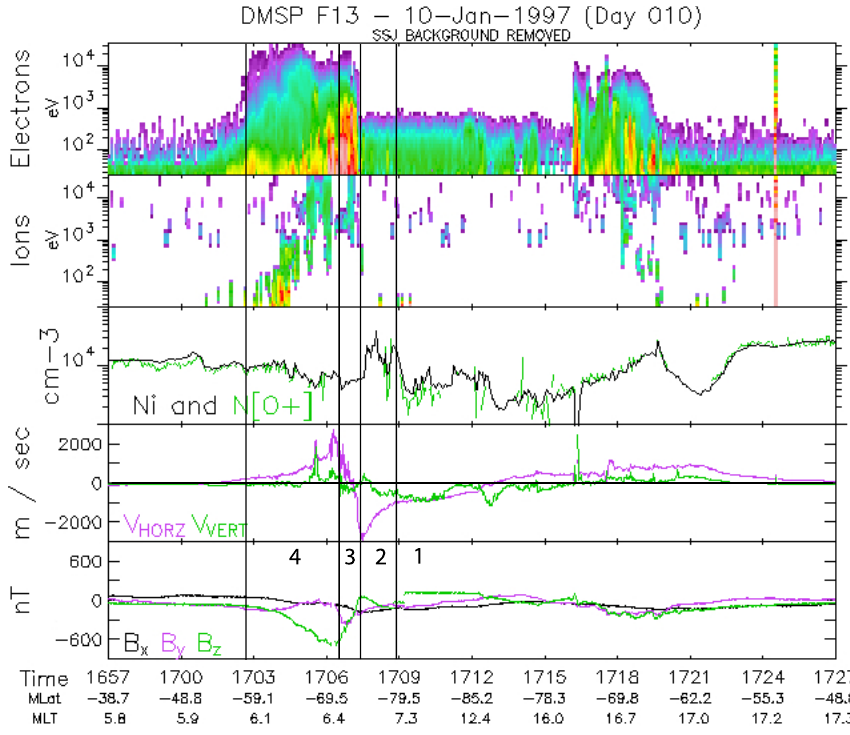
Fig. 25. Southern Hemisphere DMSP F13 data for the interval 16:57–17:27UT. Precipitation/Birkeland current regimes marked in the figure are: (1): P.RAIN (central polar cap); (2): P.RAIN and C1 current and flow channel FC 2; (3): BPS and C2/R1 current; (4): CPS and R2 current. Event category: SH-dawn/ B y < 0.